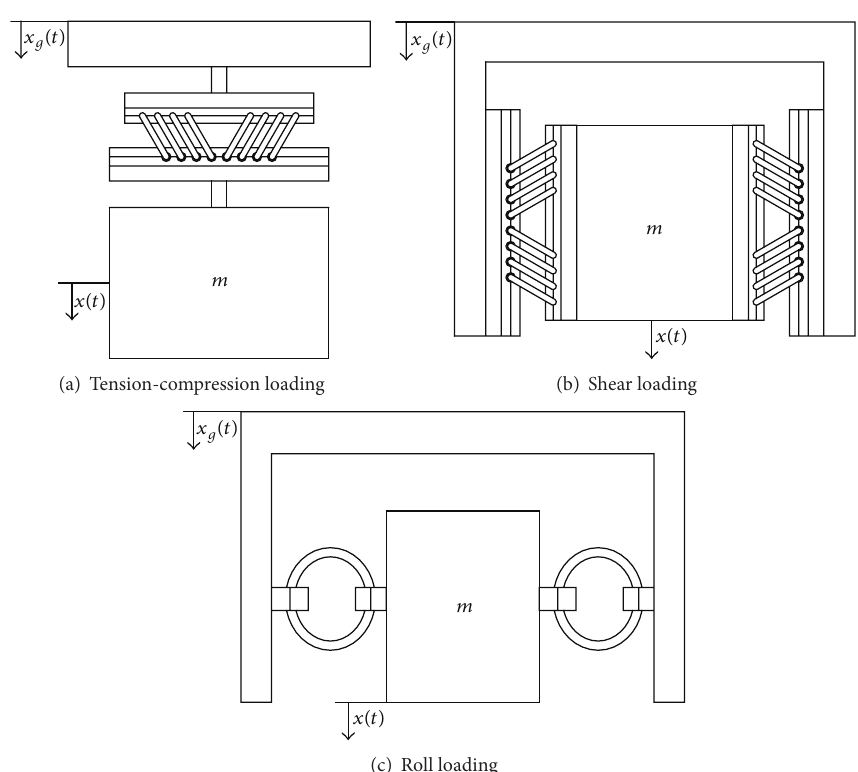
Figure 16: Systems with the